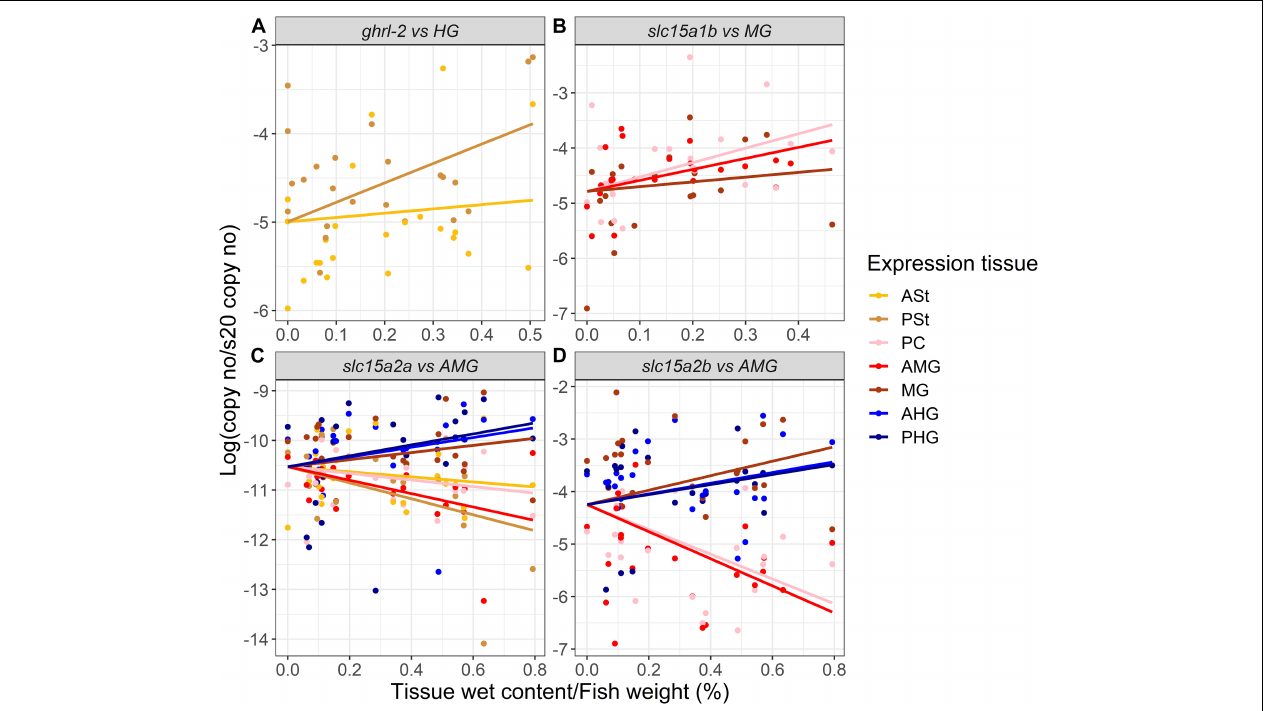
FIGURE 3 | Estimated correlation (solid line) between (A) ghrl-2 , (B) slc15a1b , (C) slc15a2a , and (D) slc15a2b mRNA expression and the gastrointestinal tract sections digesta/inner content. Raw data are represented by dots ( n = 24, except when outliers were removed as described for Figures 1 , 2 ). ASt, anterior stomach; PSt, posterior stomach; PC, pyloric ceca; AMG, anterior midgut; MG, midgut; AHG, anterior hindgut; PHG, posterior hindgut. Refer to Supplementary Table 1 for detailed